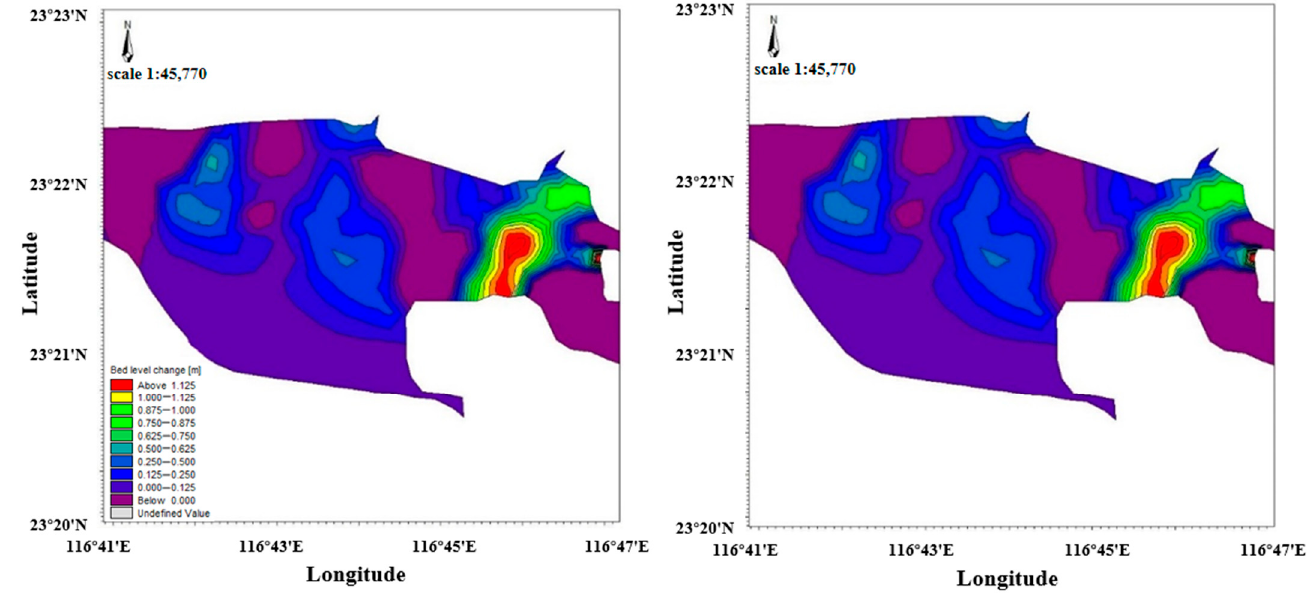
Figure 18. Changes of silts in Shantou Port before and after flood discharge of Rongjiang River.